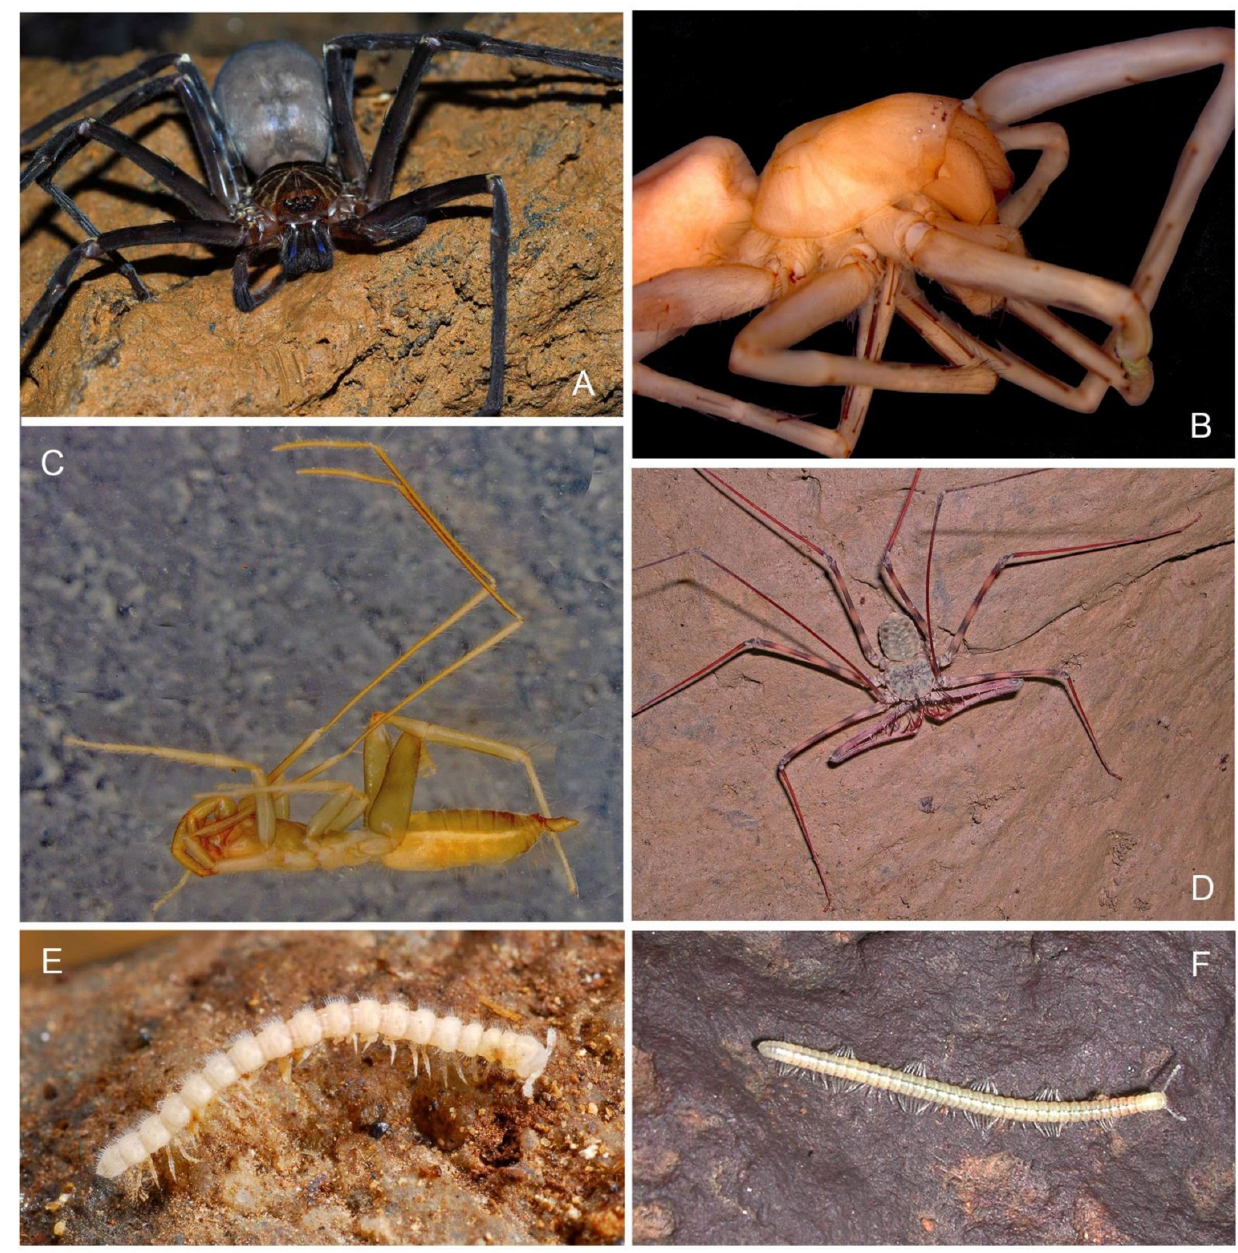
Figure 6. ( A ) Heteropoda beroni from Leang Saripa; ( B ) cf. Amauropelma sp. from Saripa spring cave; ( C ) schizomid from Gua Tanette; ( D ) Charon sp. from Saripa spring cave; ( E ) Eutrichodesmus reductus from Leang Saripa; ( F ) Hypocambala helleri from Leang Saripa. Reproduced with permission from Jean-Yves Rasplus ( A , E ) and Louis Deharveng ( B – D , F